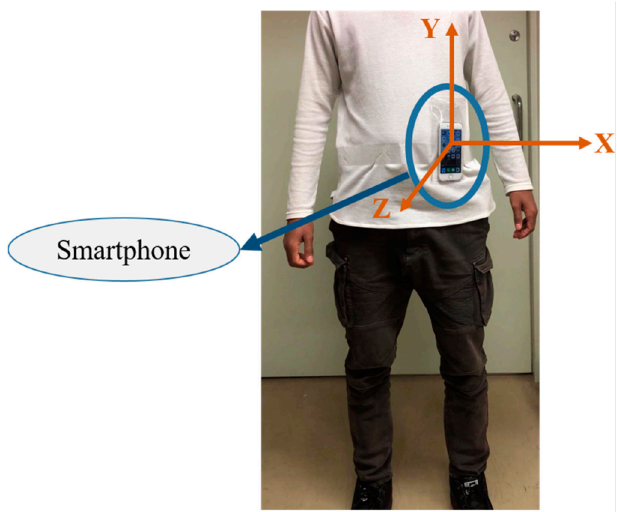
Figure 4. Smartphone (iPhone) attached to the waist as a motion sensor. An IMU (inertial measurement unit) sensor embedded in an iPhone 7, providing a 3-axis accelerometer and gyroscope data, was employed as a device for measuring the human motion kinematics. To handle sensor data in a simplified way, an exclusive iOS application software, shown in Figure 5, was developed with three main functionalities.